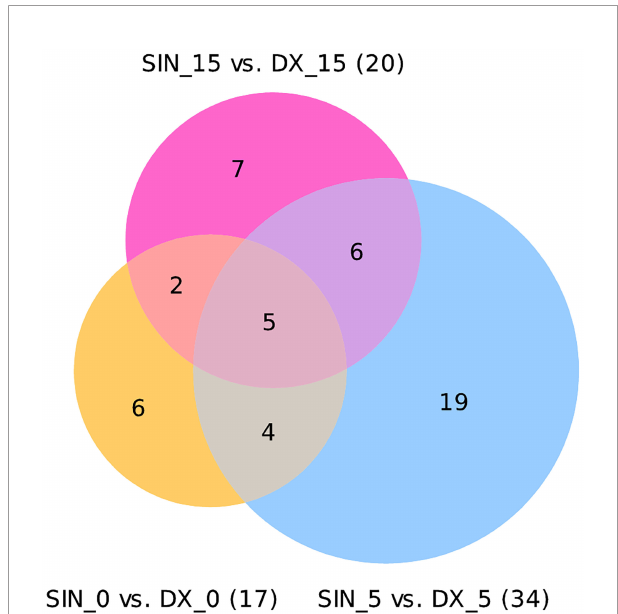
FIGURE 4 | Venn diagram of differentially expressed miRNAs in three time points. The Venn diagram represents differentially expressed miRNAs with a Bonferroni P < 0.05. In a time point of 0 minutes 17 DEMs were found 17 DEMs (12 were upregulated, 5 downregulated). In a time point of 5 minutes 34 DEMs were found (20 upregulated,14 downregulated). In a time point of 15 minutes 20 DEMs were found (11 upregulated, 9 downregulated).